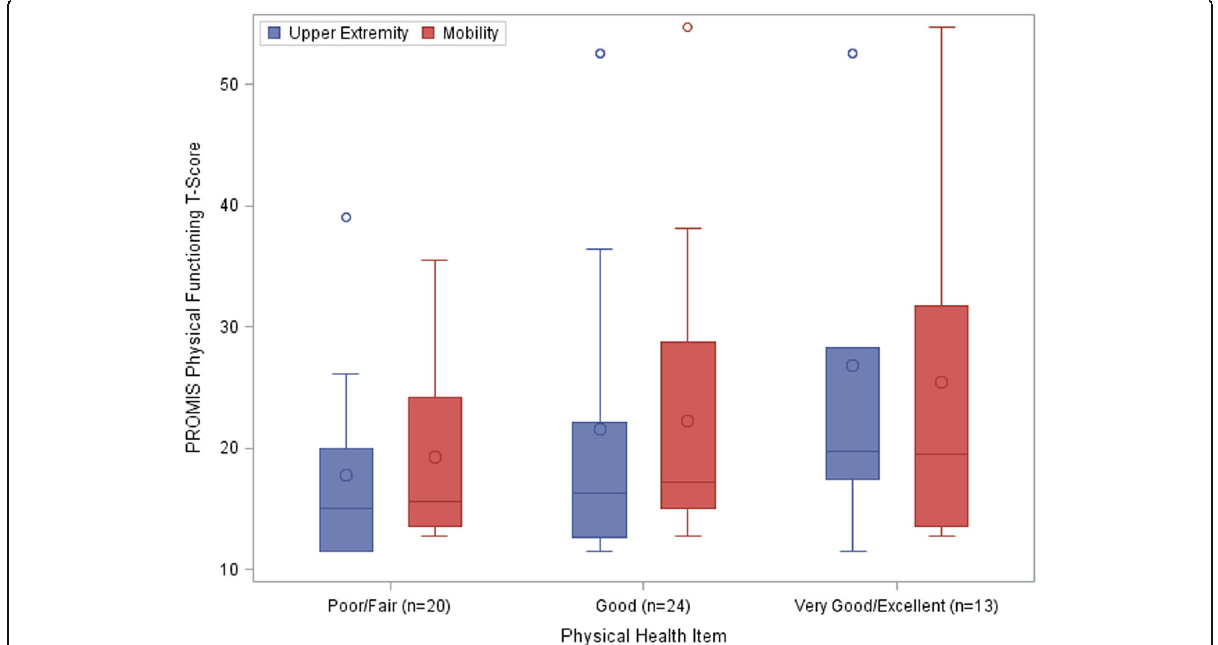
Fig. 1 Boxplots of PROMIS physical function T-scores by physical health item score. Spearman correlation for Upper Extremity: r = 0.28 ( p = 0.04); Spearman correlation for Mobility: r = 0.15 ( p = 0.26). Note: the line within the box represents the median; the circle within the box represents the mean; the length of the box represents the interquartile range; the length of the whiskers represents the distance between the box and the observation that is less than 1.5 times the interquartile range; the points outside the whiskers represent outliers